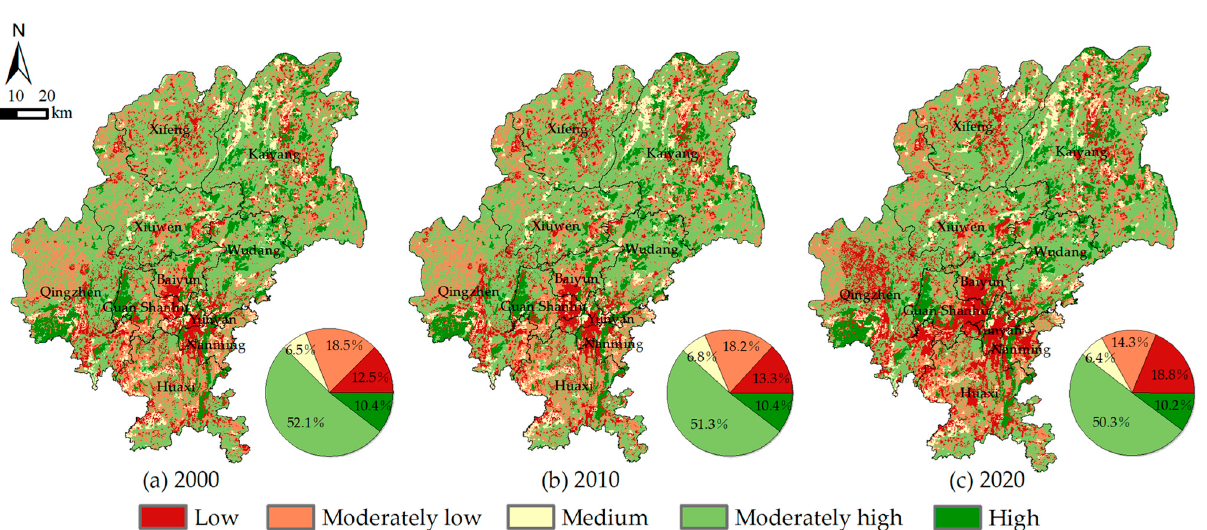
Figure 3. Spatial zoning scheme for the territory of Guiyang city.